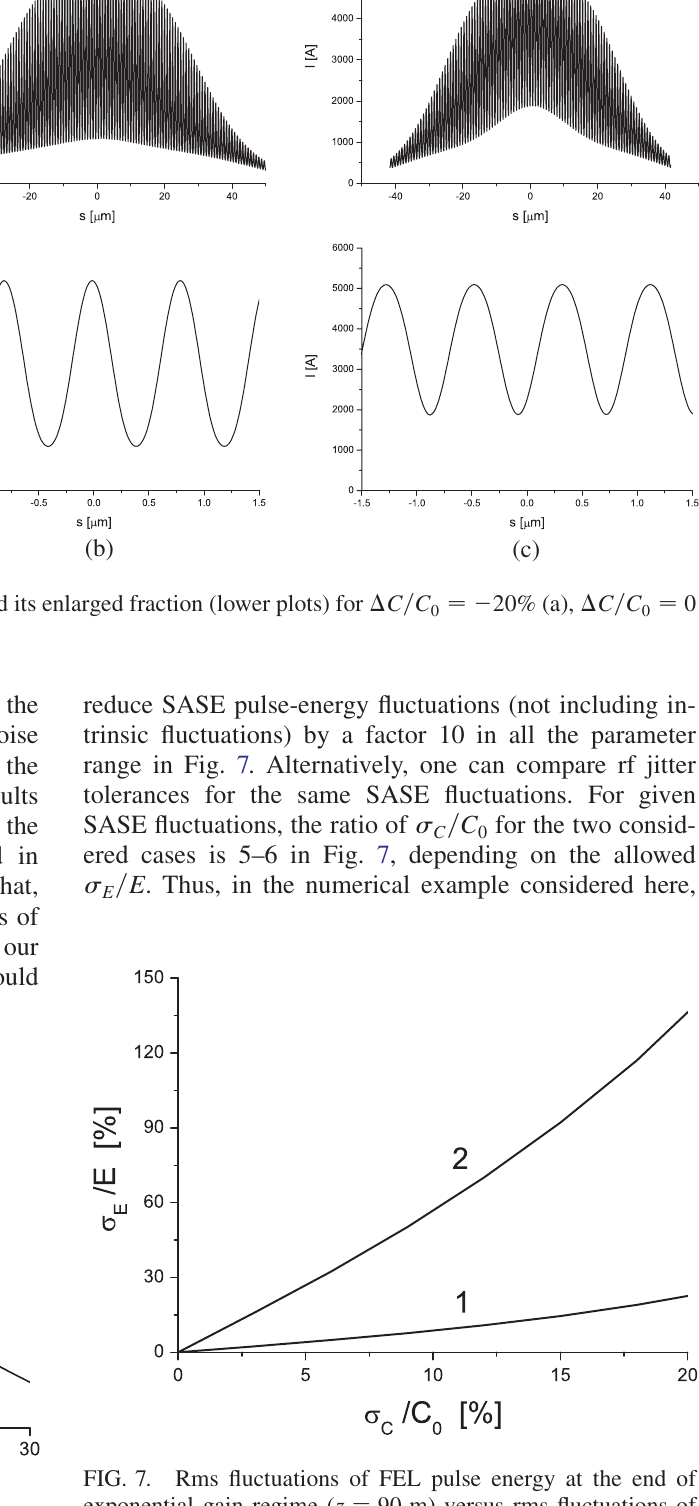
FIG. 6. Deviation of peak current after BC3 versus deviation of the compression factor in the main compression system (after